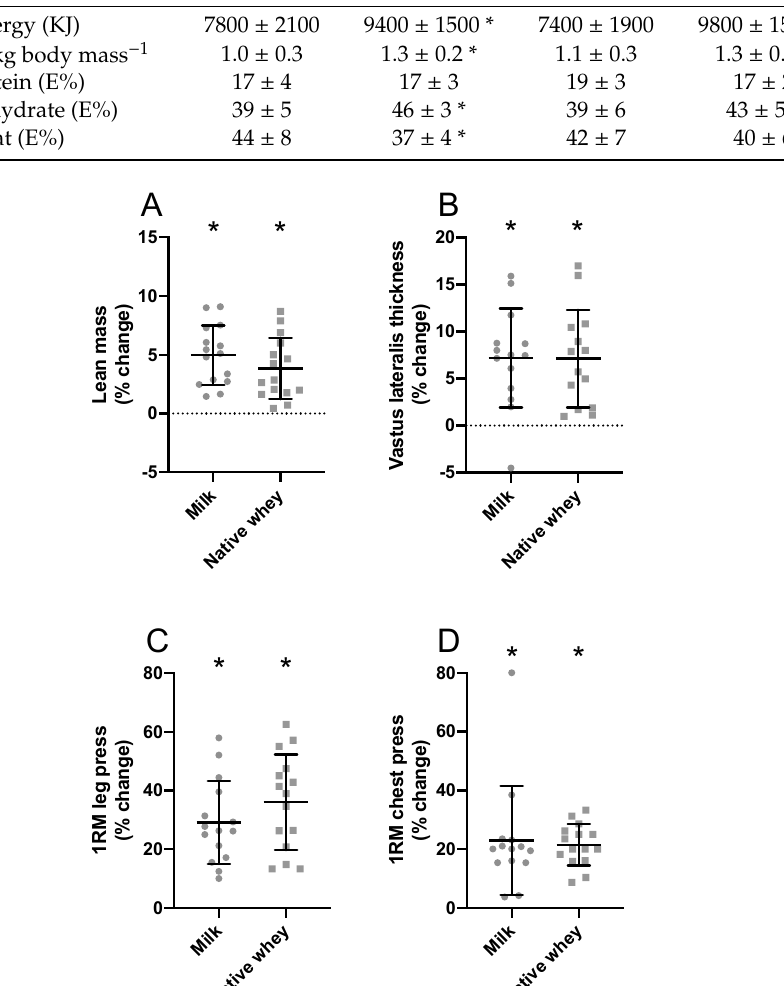
Figure 3. Relative changes in lean mass ( A ), m. vastus lateralis thickness ( B ), 1 RM leg press ( C ), and 1 RM bench press ( D ) after a 12-week strength training and protein supplementation period in the elderly. Values are mean ± SD. n = 15 and 15 in the milk group and native whey group, respectively. * different from baseline, p < 0.05.